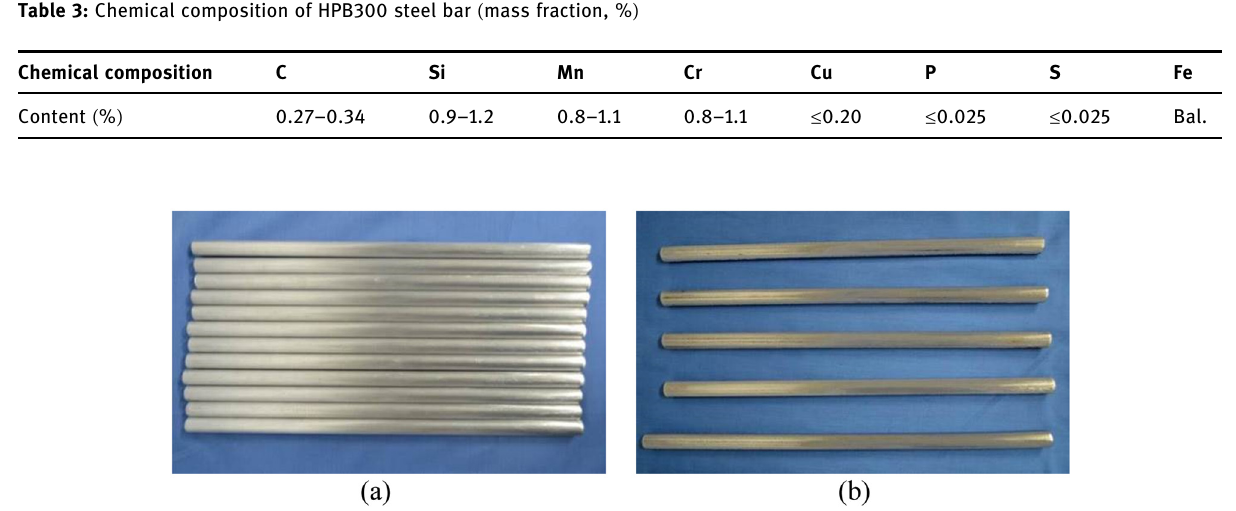
Table 3: Chemical composition of HPB300 steel bar ( mass fraction, % )